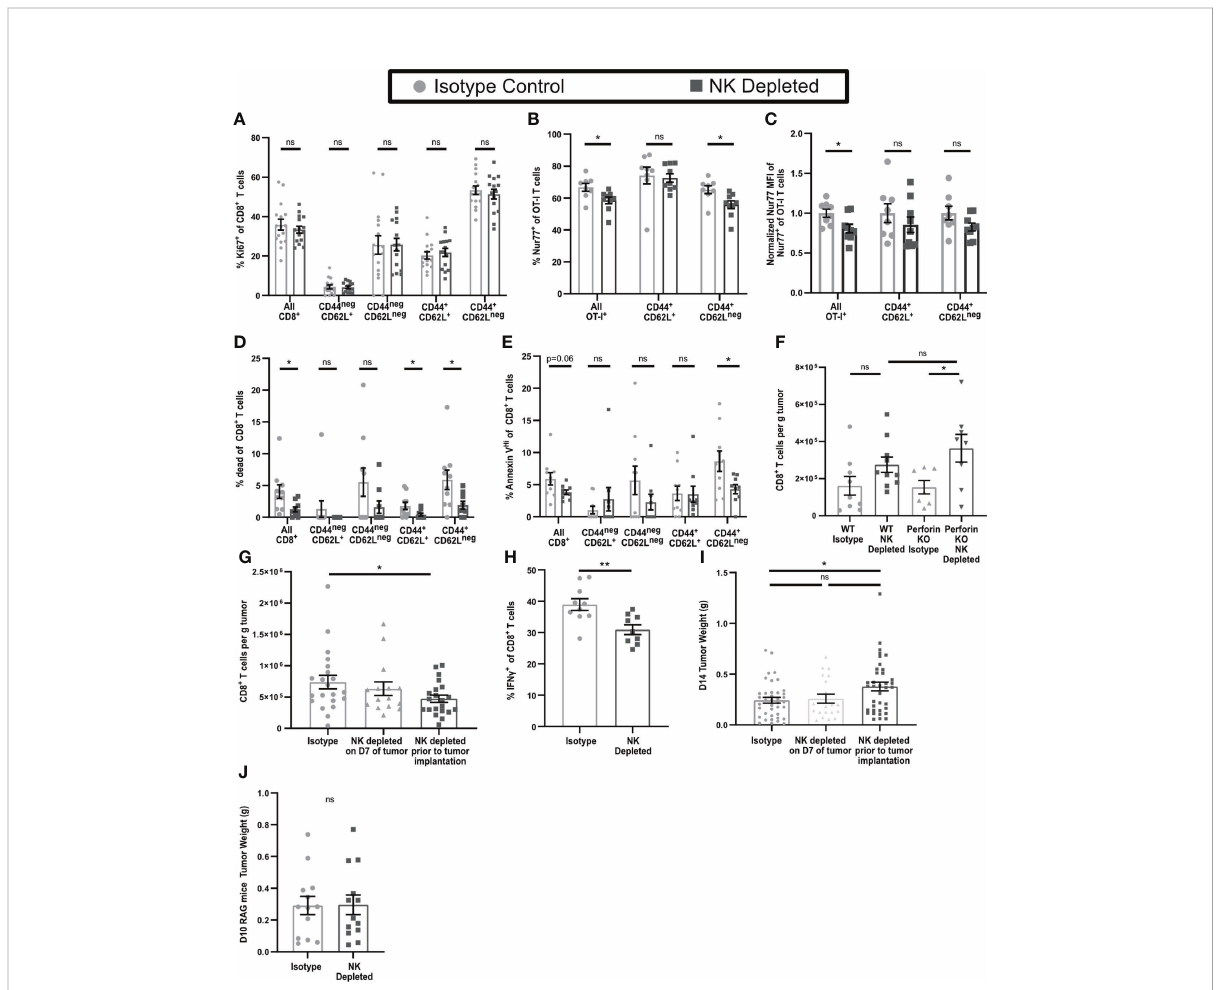
FIGURE 4 Dysfunctional CD8 + T cells in tumors from mice lacking NK cells display an anergic phenotype. B16-ova tumors were implanted into WT B6 (A – H) or Perforin ko (F) mice, with or without NK cell depletion. Anti-NK1.1 depleting antibody was administered prior to tumor implantation and maintained with additional treatments every three days (A – J) or on D7 after tumor implantation (G, I) . Single cell suspensions were enriched for CD45 + cells using MACS Beads and analyzed by fl ow cytometry (A – H) . Mice were treated with BFA for cytokine analysis 4-6 hours prior to tumor harvest (H) . Tumors were harvested on D7 (A – F) , D14 (G – I) . (B, C) Nur77-GFP + Thy1.1 + OT-I T cells were adoptively transferred into recipient mice prior to tumor implantation to monitor antigen speci fi c TCR signaling. Nur77 MFI was normalized to the Isotype control average for each individual experiment. (J) Tumors were implanted in RAG mice and harvested on D10 by which time tumor size endpoints were reached in some mice. Data is from: (A) 4 experiments; (B, C) 2 experiments; (D, E) 2 experiments; (F) 2 experiments; (G) 6 experiments; (H) 2 experiments; (I) 8 experiments; (J) 3 experiments. Statistics: (A – E, H, J) Unpaired Student ’ s T test with Welch ’ s correction; (F, G, I) One-way Anova with Tukey ’ s posttest. *p < 0.05; **p < 0.01; ns, not signi fi